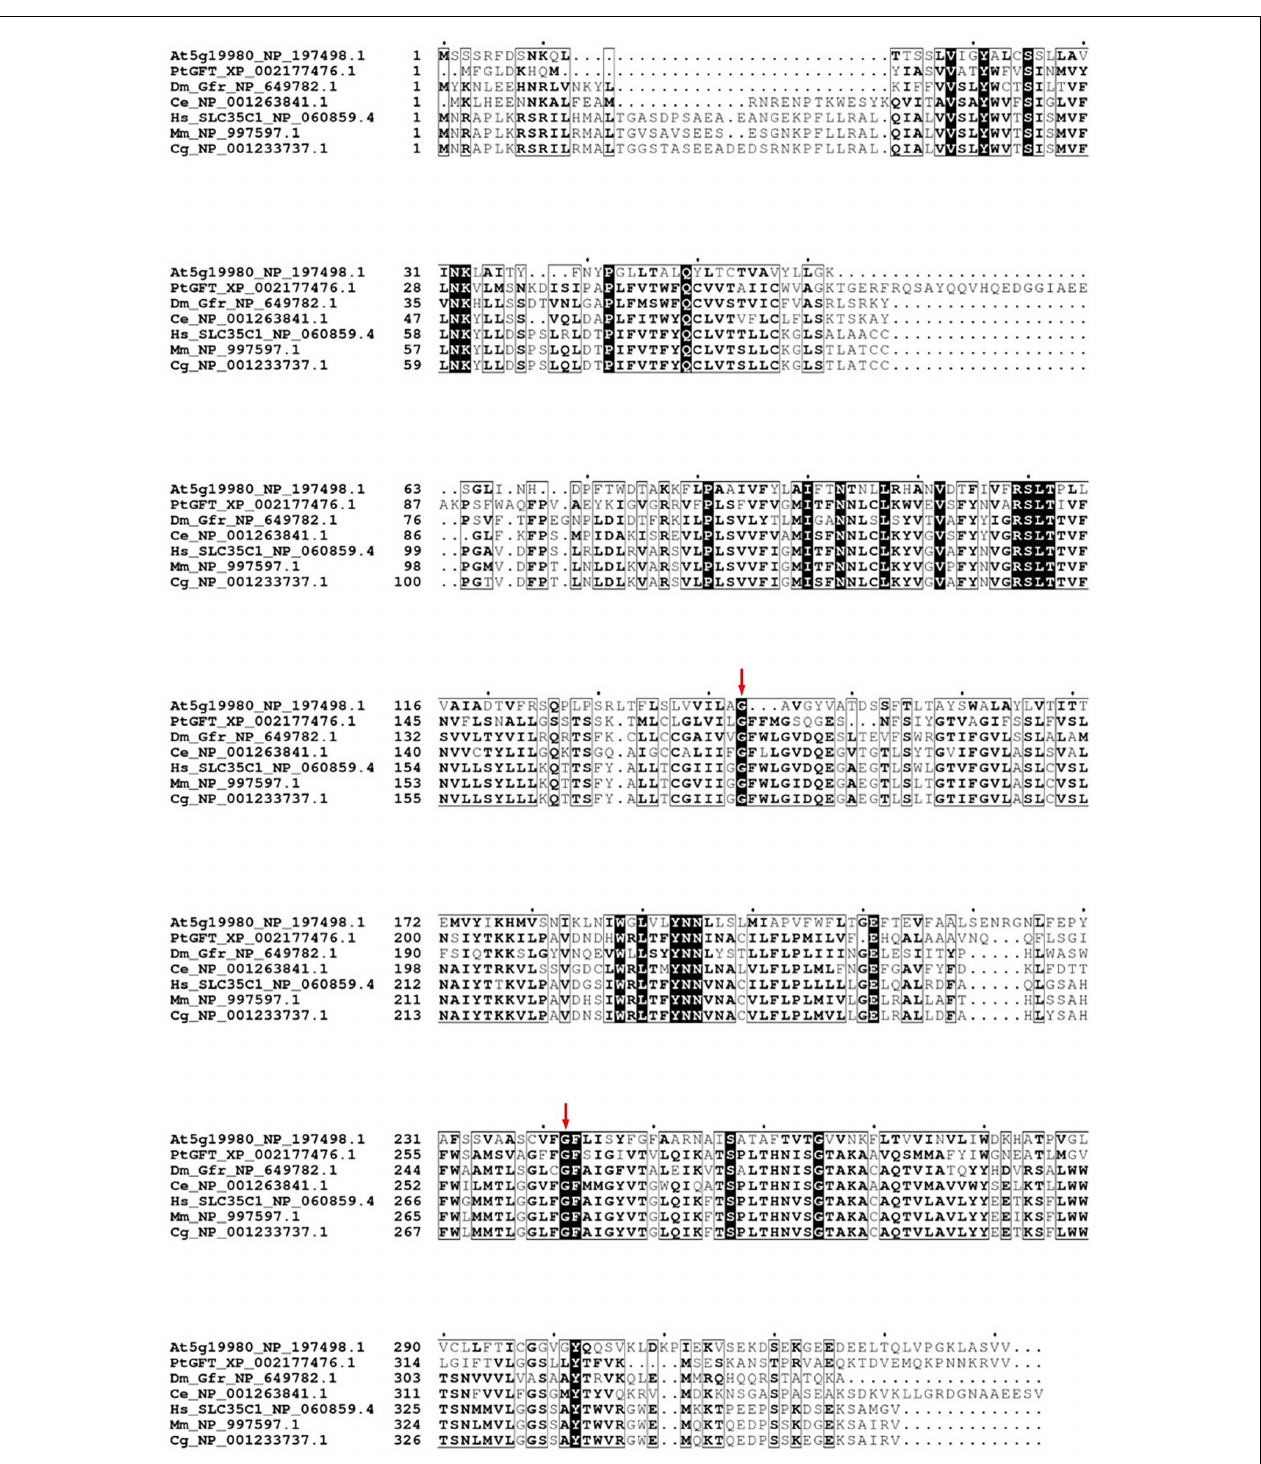
FIGURE 2 | Phaeodactylum tricornutum putative GFT (PtGFT) exhibits strong amino acid identities with other eukaryotic GDP- L -fucose transporters. Multiple alignments of GDP- L -fucose transporters protein sequences from H. sapiens (NP_060859.4; SLC 35C1 gene), M. musculus (NP_997597.1; SLC 35C1 gene), C. griseus (NP_001233737.1; SLC 35C1 gene), C. elegans (NP_001263841.1; nstp-10 gene), D. melanogaster (NP_649782.1; Dm_Gfr gene); A. thaliana [NP_197498.1; At5g19980 (GFT1/GONST4) gene], and PtGFT (XP 002177476.1) with the MUSCLE program (https://www.ebi.ac.uk/; Edgar, 2004). The figure was created with the Espript program (http://espript.ibcp.fr/ESPript/ESPript/index.php; Robert and Gouet, 2014). The two red arrows highlight the glycine residues positions 171 and 266, respectively, in the PtGFT_XP_002177476.1 sequence.